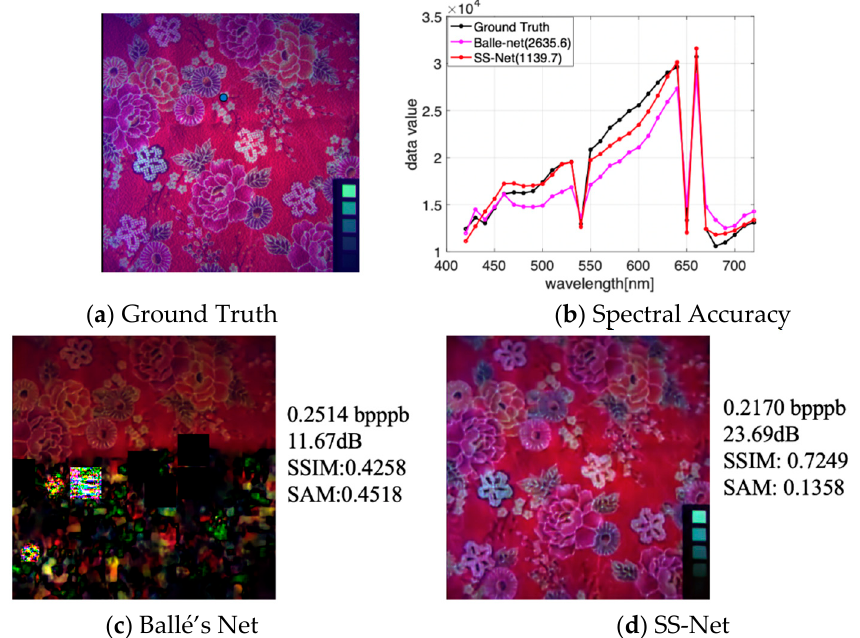
Figure 7. Impact of the SS-Net for HSI compression, false color (composed of bands 25, 10, 1), λ = 0.0000001. ( a ) is the original spatial domain, also called ground truth; ( b ) shows the results of spectral accuracy comparisons for the bule point (169, 243) in the ground truth, and the number in the chart is the value of RMSE (root mean squared error; a small value shows a better spectral accuracy); ( c ) denotes the reconstructed HSI without considering the difference between the spectral dimension and the spatial domain; ( d ) represents the reconstructed HSI with SS-Net.